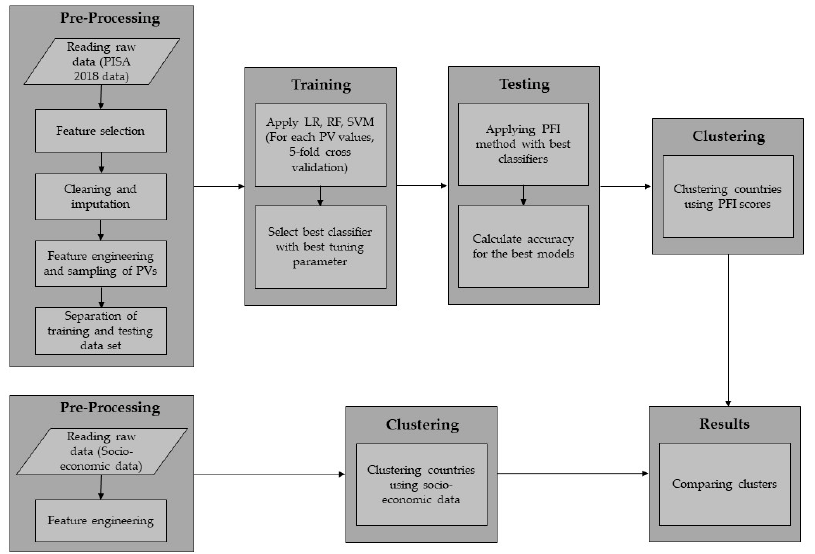
Figure 1. Flowchart of